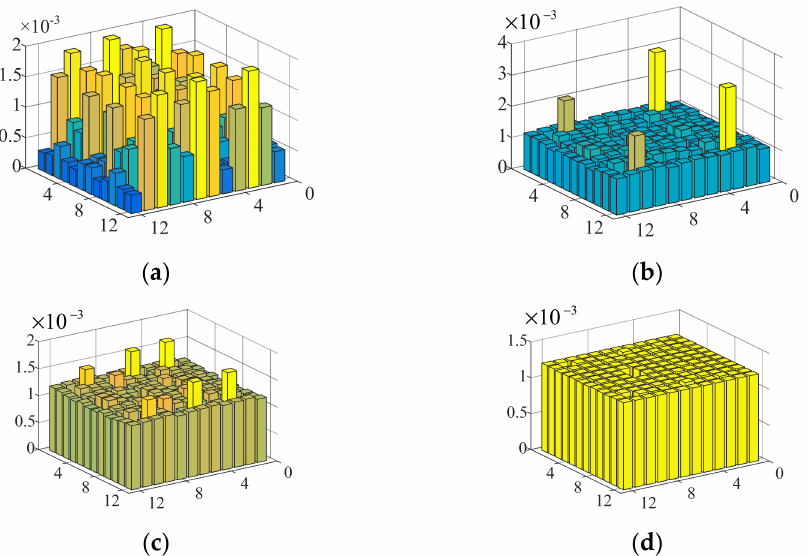
Figure 6. Iterative optimization for uniform amplitude. ( a ) Amplitude with 0 iterations (without optimization). ( b ) Amplitude with 1 iterations. ( c ) Amplitude with 3 iterations. ( d ) Amplitude